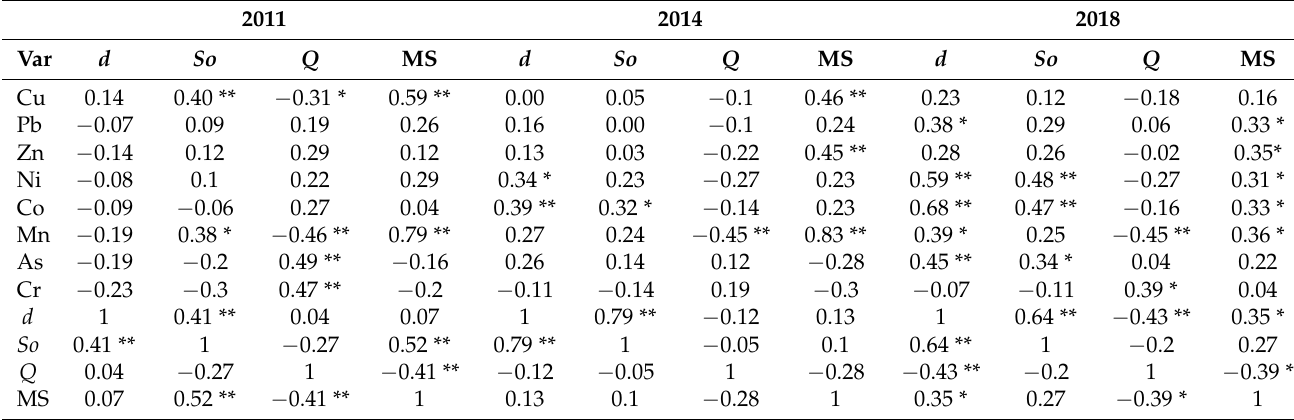
Table 2. Pearson’s correlation coefficient between trace metals and mean grain size (d, mm), sorting coefficient ( S o ), beach sediment volume ( Q , m3/m), and magnetic susceptibility (MS, µ